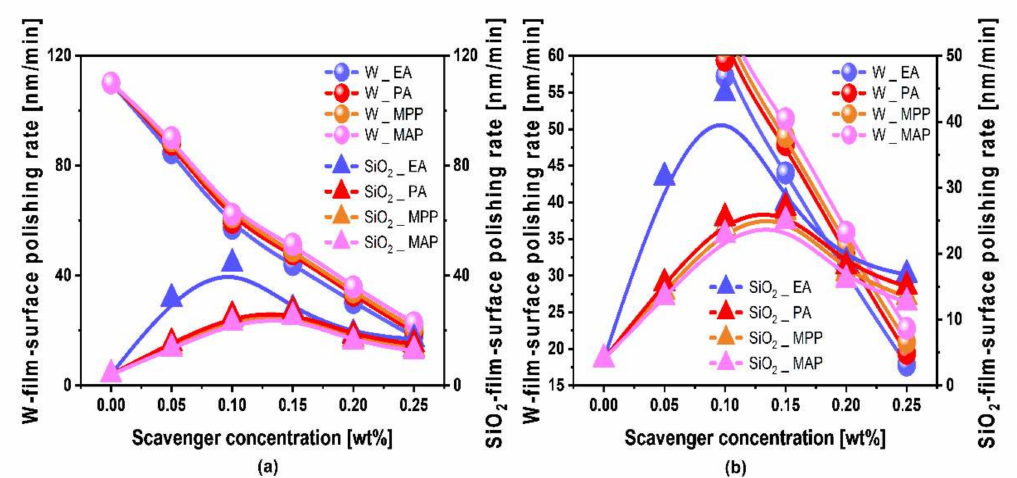
Figure 2. CMP performance of W-film surface slurries. ( a ) W- and SiO 2 -film surface polishing rates depending on the scavenger type and concentration; ( b ) magnified W- and SiO 2 -film surface polishing rates from ( a